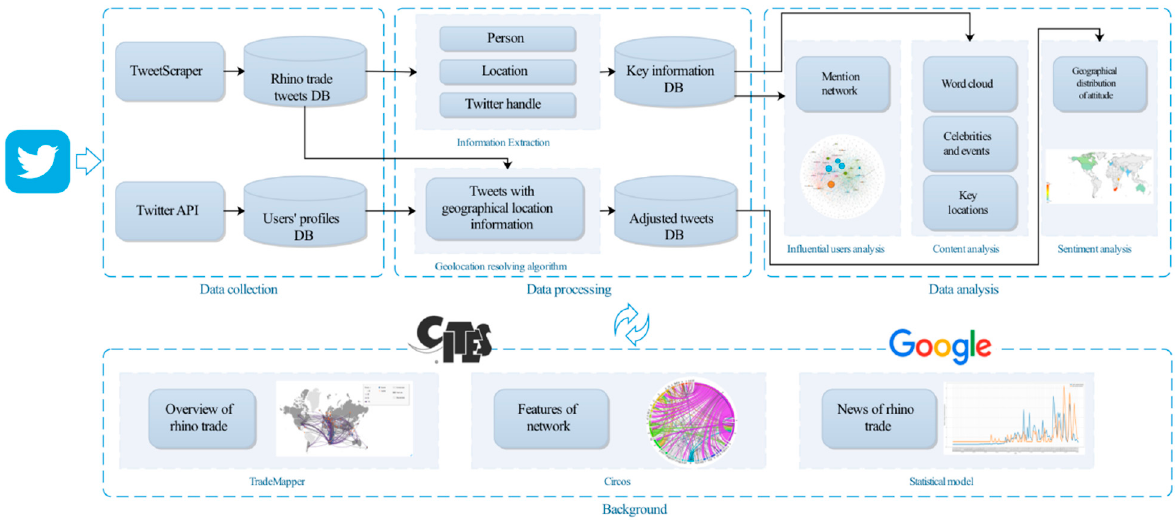
Figure 2. The framework of research.